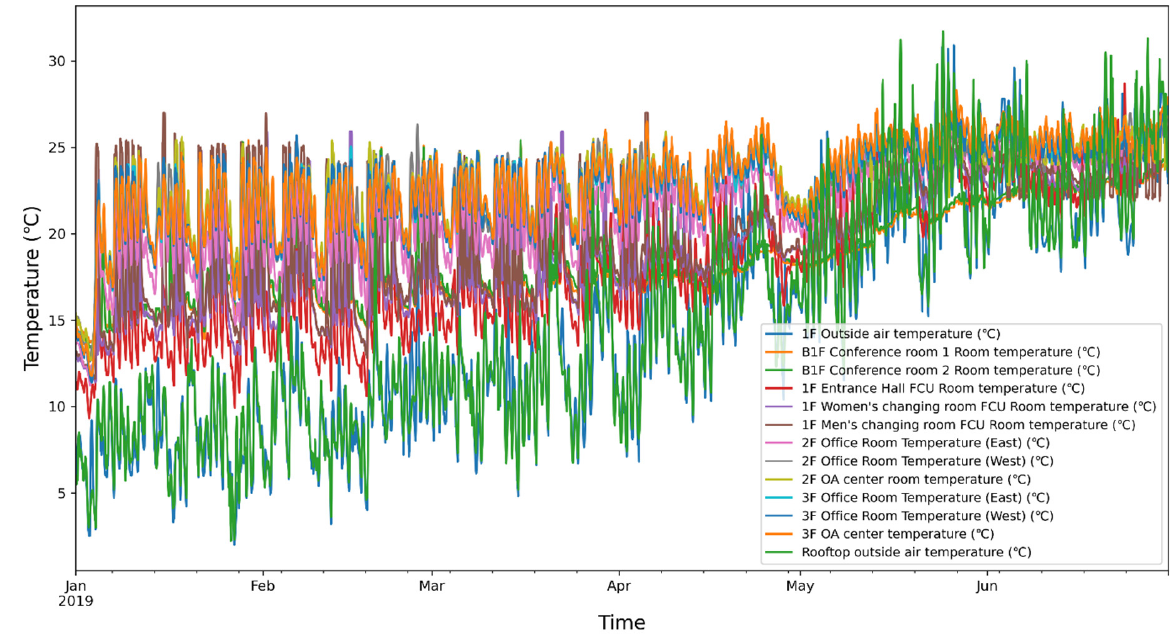
Figure 2. Recorded temperature data for the